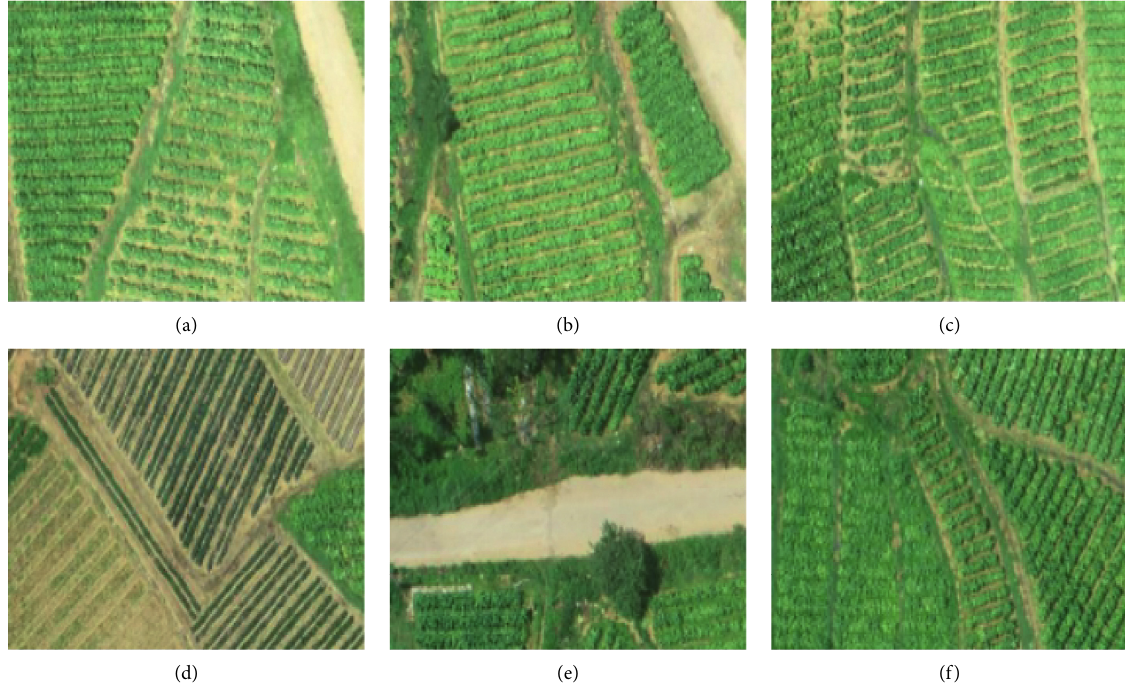
Figure 5: Tobacco in different